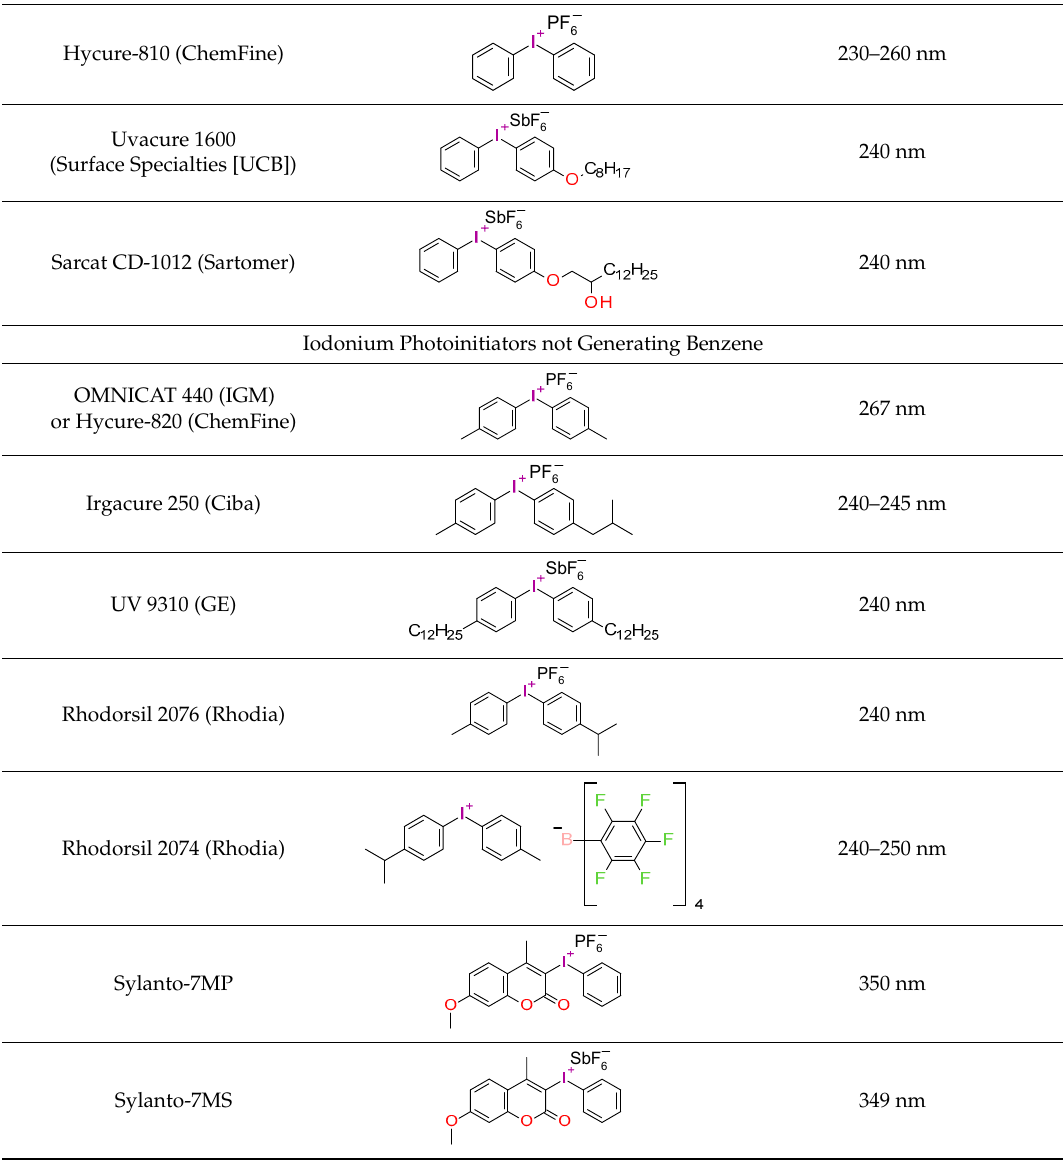
Table 3. Commercial iodonium photoinitiators used in industrial practice [196].